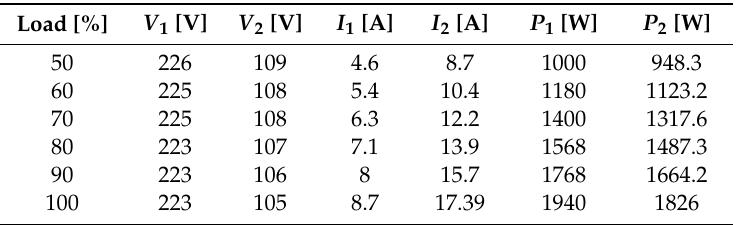
Table 4. Load data of a single-phase transformer [11].